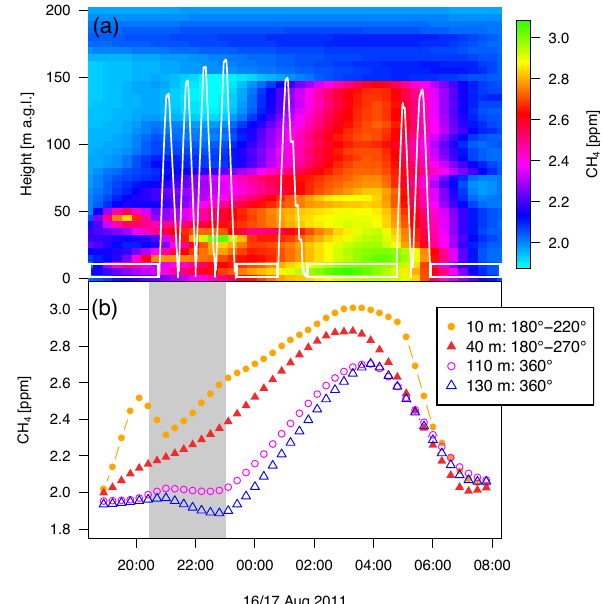
Figure 2. (a) Kriged time–space interpolation of the CH 4 concen- trations obtained from the balloon and near-surface (0–10 m) mea- surements during 16/17 August 2011, including rejected measure- ments not used for NBL budget estimates. Vertical and horizontal kriging directions were equally weighted, resulting sometimes in sharp vertical concentration changes. The balloon position is shown with a white line, whereas the near-surface concentration measure- ments are shown with a white box. (b) Nocturnal course of CH 4 concentrations at 10, 40, 110, and 130ma.g.l.: the grey shaded time period shows the period when the wind direction changes from easterly (around 20:00) to south-westerly winds (180–270 ◦ , down- valley direction) near the surface and anti-wind (in opposite direc- tion) aloft (see legend for details). This clear separation between the down-valley wind and its anti-wind during the August 2011 cam- paign explains why a relatively low z i of only 50m resulted for the integration of the NBL budget fluxes (see Table